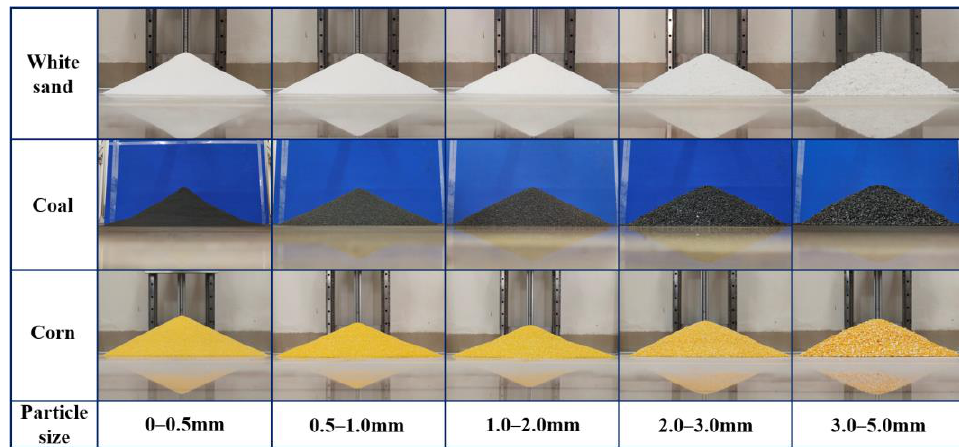
Figure 3. Material stacking experiment.